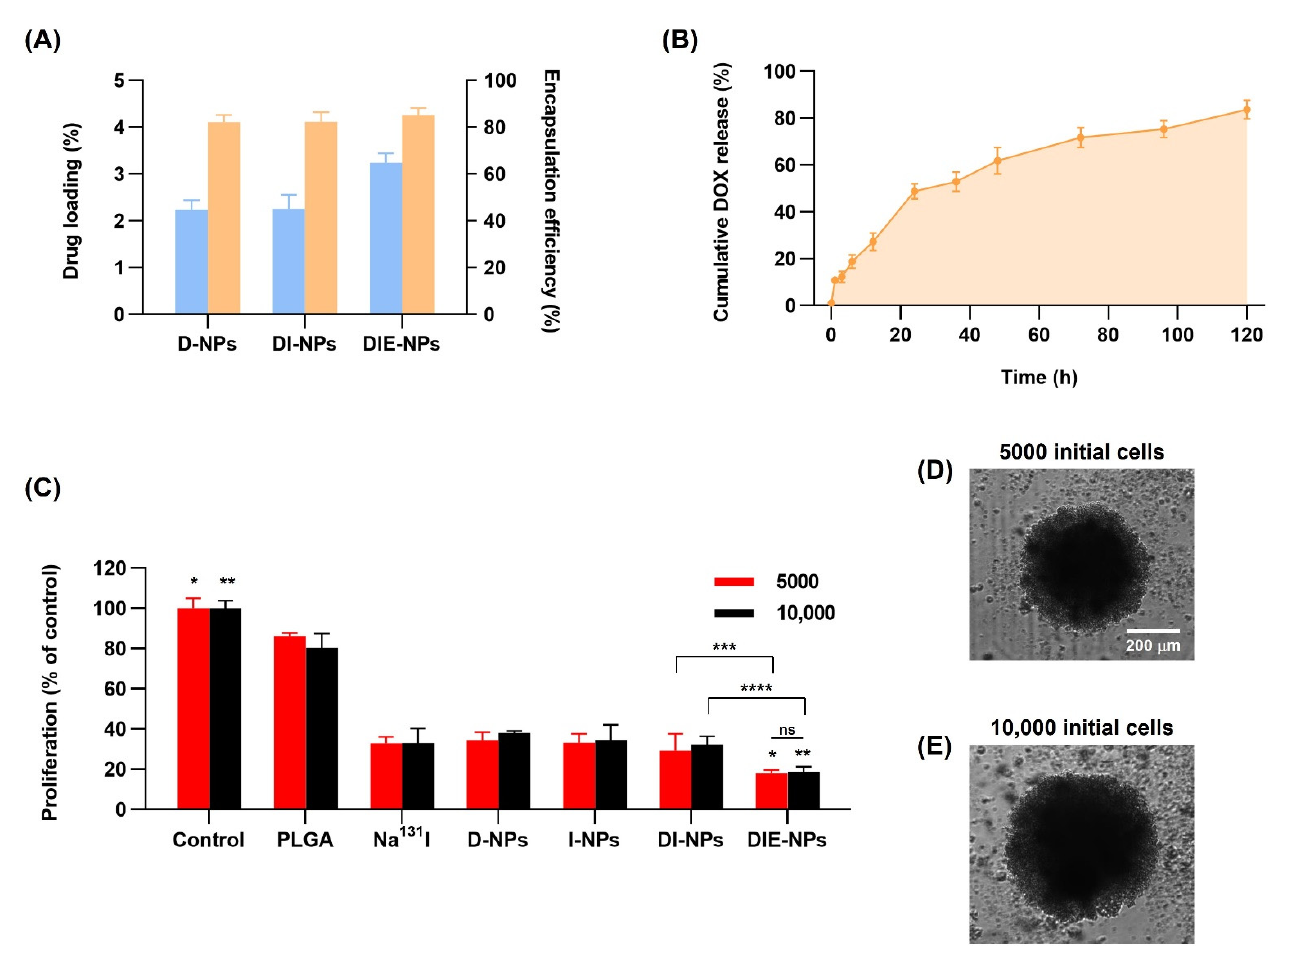
Figure 6. Therapeutic efficiency of nanoparticles. ( A ) Drug loading and encapsulation efficiency of D-NPs, DI-NPs, and DIE-NPs. ( B ) Cumulative amount of DOX release after 0, 1, 3, 6, 12, 24, 36, 48, 72, 96, and 120 h. ( C ) In vitro three-dimensional (3D) MG-63 human tumor spheroid proliferation (% of control) using Cell Titer-Glo ® 3D cytotoxicity assay of DIE-NPs compared to control, PLGA, Na 131 I, D-NPs, I-NPs, DI-NPs, and DIE-NPs treatment of 5000 initial cells/well and 10,000 initial cells/well after 72 h incubation. ns = no statistically significant difference in efficacy of proliferation (% of control) between DIE-NPs treatment of 5000 and 10,000 initial cells/well ( p > 0.05). * denotes significance between control and DIE-NPs of 5000 initial cells/well ( p < 0.05). ** denotes significance between control and DIE-NPs of 10,000 initial cells/well ( p < 0.05). *** denotes significance between DI-NPs and DIE-NPs of 5000 initial cells/well ( p < 0.05). **** denotes significance between DI-NPs and DIE-NPs of 10,000 initial cells/well ( p < 0.05). ( D,E ) The morphology of three-dimensional (3D) MG-63 human tumor spheroid of 5000 and 10,000 initial cells were imaged in bright-field using LionHeart live cell imaging. [10 × images, scale bar = 200 µm]. Data are given as mean ± standard deviation ( n = 3).